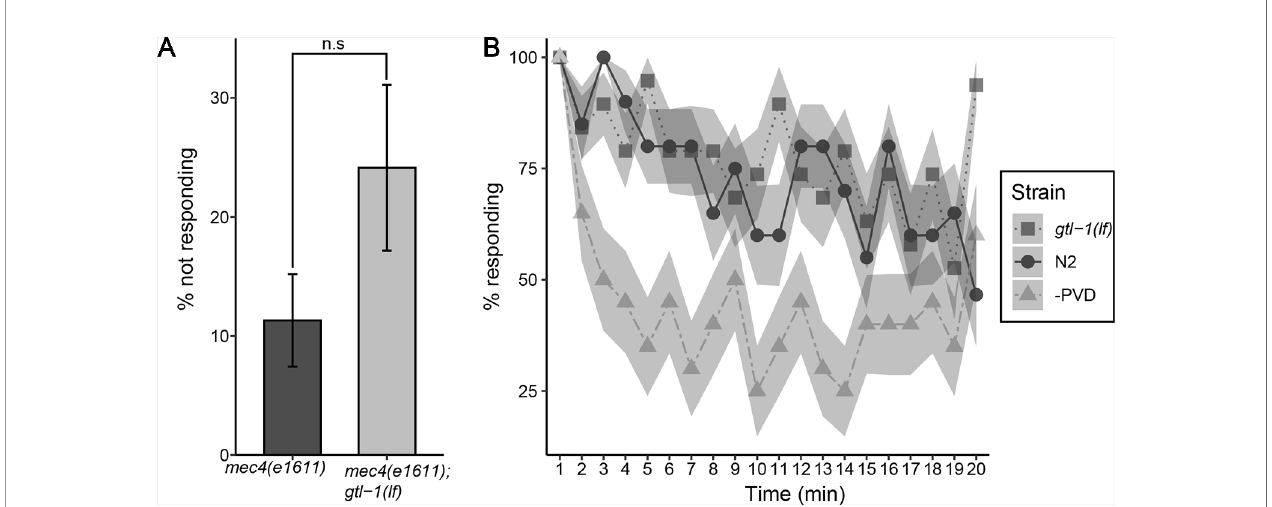
FIGURE 3 | GTL-1 is not essential for the response to single or repeated mechanical stimuli. (A) Percent animals not responding to a single high threshold mechanical stimuli in mec-4(e1611); gtl-1(lf) and in mec-4(1611) animals (20 and 11 plates, respectively, 10 animals each plate). Statistical analysis was performed using n.s, p = 0.086. (B) Responses to repeated high threshold mechanical stimuli in gtl-1(lf) animals (n = 20), wild-type (N2, n = 20), and -PVD (n = 20)